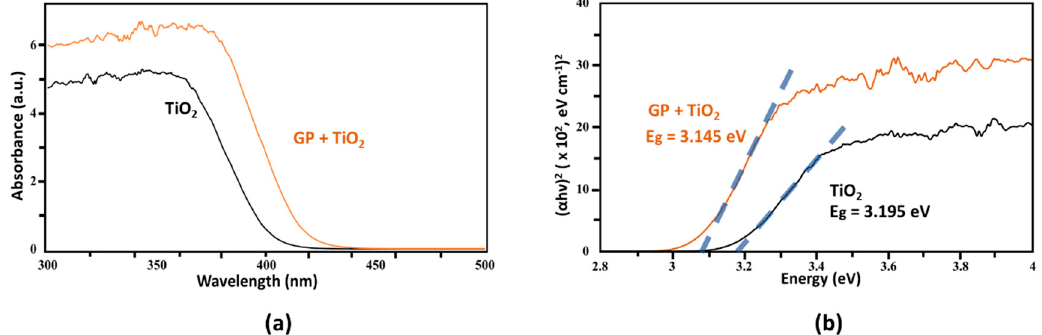
Figure 7. ( a ) UV-Vis di ff use absorbance spectra and ( b ) Tauc plot of TiO 2 and GP + TiO 2